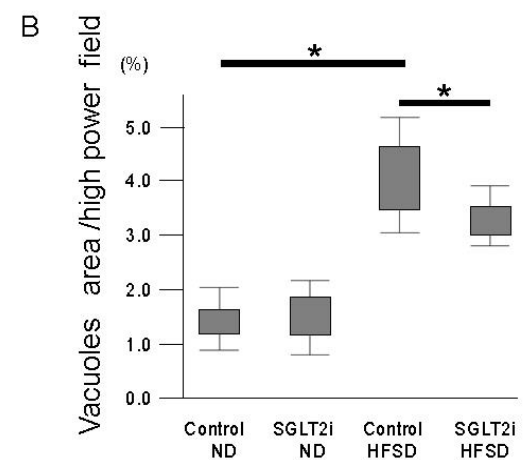
Figure 2. SGLT2 inhibitor (SGLT2i) decreased lipid accumulation in renal proximal tubular cells